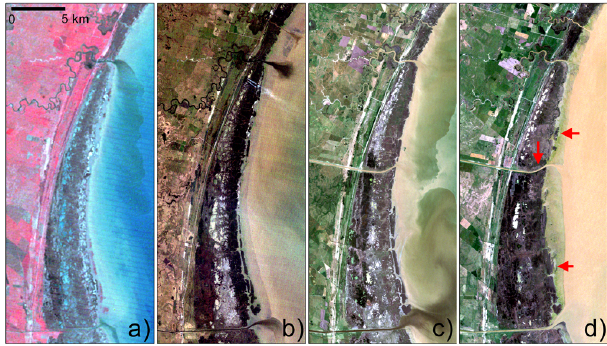
Fig. 4. Landsat images of the central sector of the Samboromb´on coast dated (a) 20 September 1976, (b) 25 June 1987, (c) 30 Novem- ber 1998, and (d) 1 October 2011. The red arrows in (d) highlight the zones where the progradation of the salt marsh areas are more